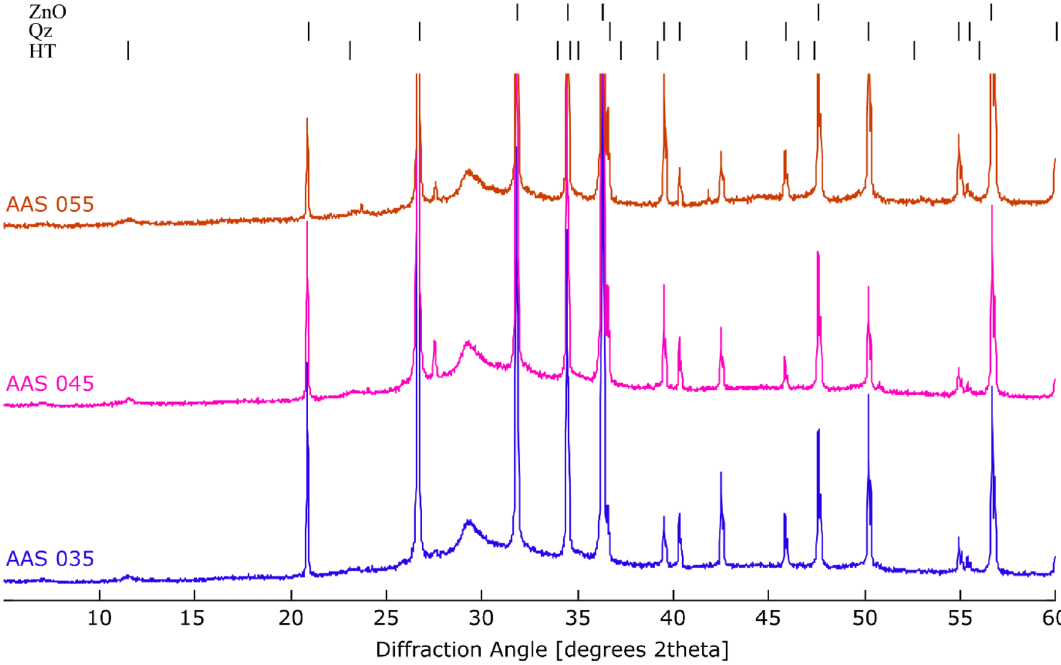
Figure 2. XRD diffractograms of the reference specimens of each water to binder ratio: ZnO zincite internal standard, Qz quartz, HT